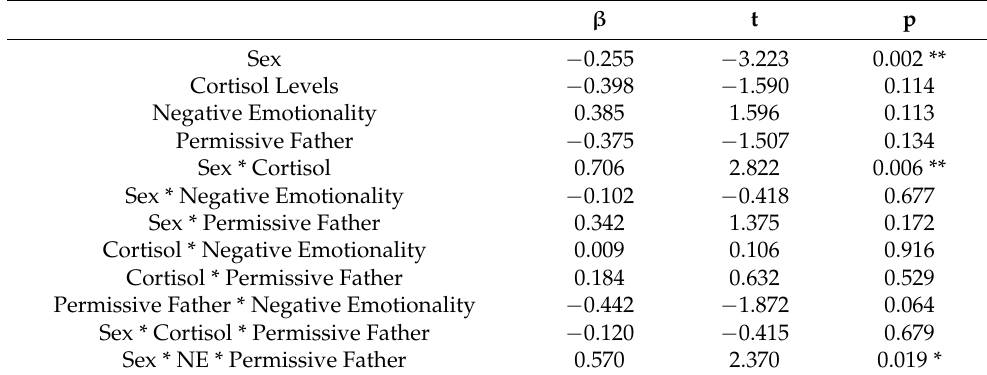
Figure 1. Interaction between cortisol levels and authoritative father in relation to aggressive behavior in boys. Table 5. Regression analysis for aggressive behavior including permissive father and negative